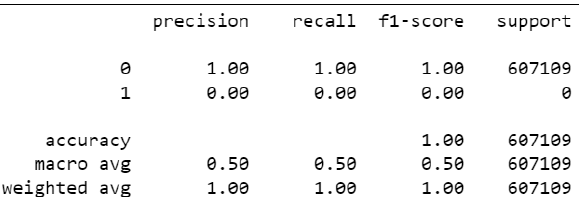
Table 3: Artificial Neural Networks classification report.